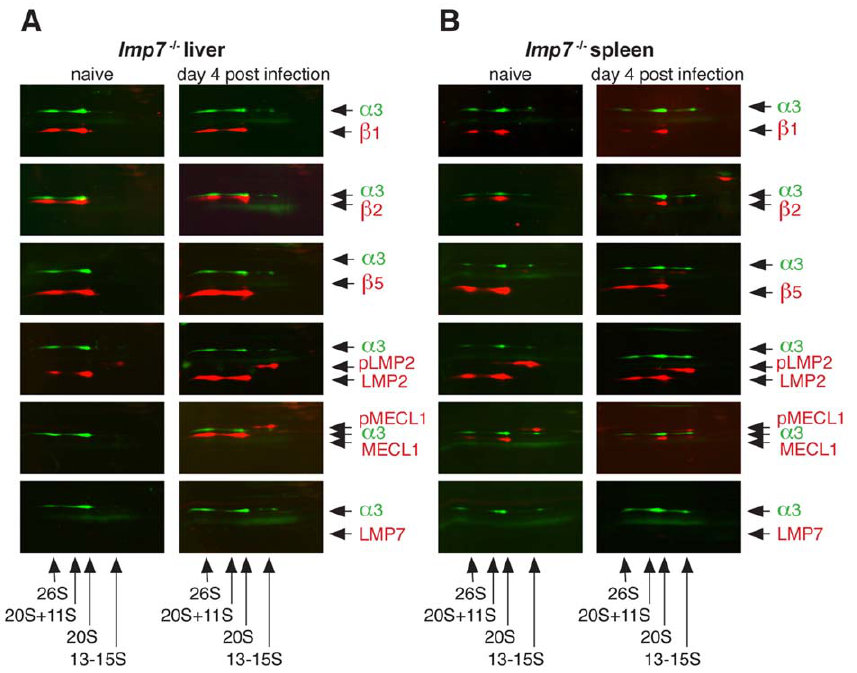
Figure 4. Analysis of proteasome composition in naive and listeria-infected lmp7 2 / 2 mice. Organ lysates of liver (A) and spleen (B) of naı¨ve and infected lmp7 2 / 2 mice were analysed by 2D two-colour fluorescent immunoblot analysis. The mice were infected i.v. with 5 6 10 3 cfu L. monocytogenes and sacrificed 4 days post infection. Organs of three to four mice per group were pooled for the analysis. The different proteasome complexes present in the tissues were first separated by Blue Native-PAGE and subsequently by SDS-PAGE followed by two-colour fluorescent immunoblot analysis. Each membrane was stained for proteasome subunit a 3 (green signal) and as it is present in all early to mature complexes in proteasome assembly, a 3 serves as a marker for the presence and positions of 13-15S precursor proteasomes, 20S proteasomes and 20S proteasomes + 11S and 19S regulators. Further, membranes were stained for the indicated catalytic b -subunits (red signals) to identify, in which of the indicated proteasome complexes they were integrated.